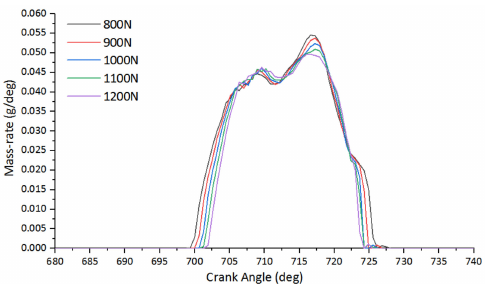
Figure 17. Fuel injection rate under varied needle valve opening pressures.